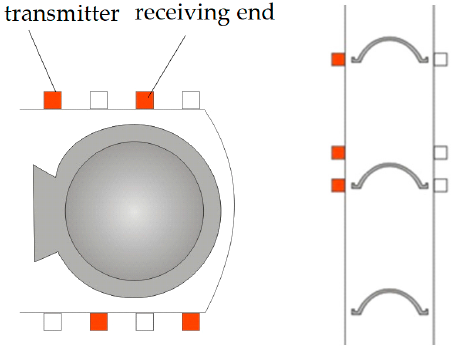
Figure 22. Monitoring location. Reprinted with permission from ref. [90]. Copyright 2013 Northwest A&F University.